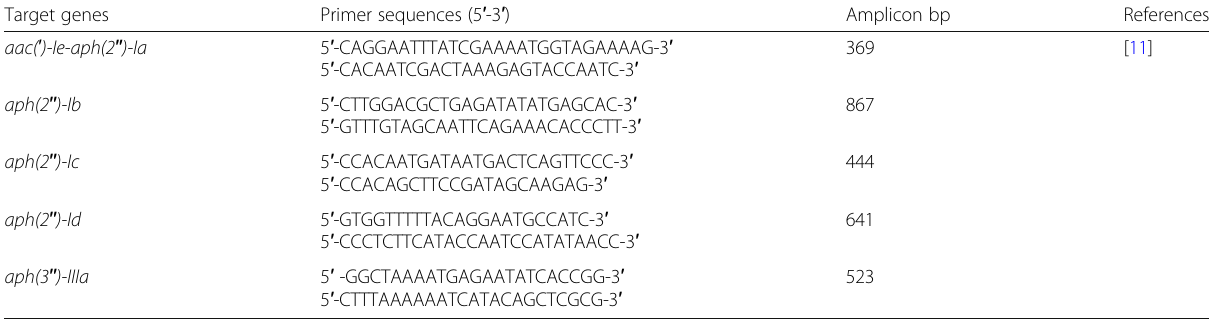
Table 1 Primer sequences for amplification of aminoglycoside resistance genes used in PCR assay Target genes Primer sequences (5 ′ -3 ′